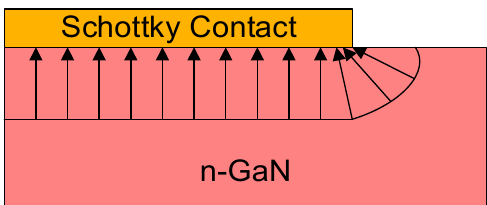
Figure 4. Electric field distribution of a typical vertical SBD under reverse bias.